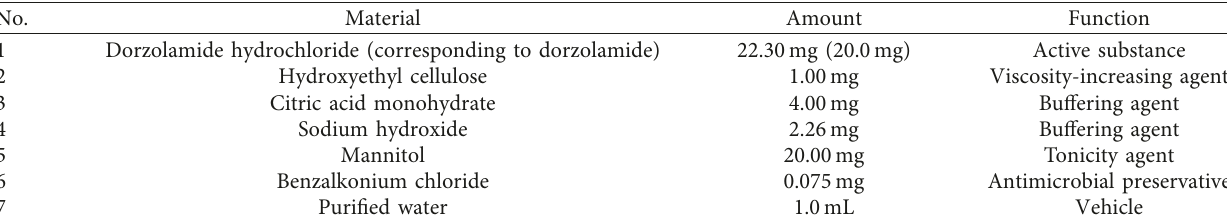
Table 2: Final formula for dorzolamide 2% eye drops